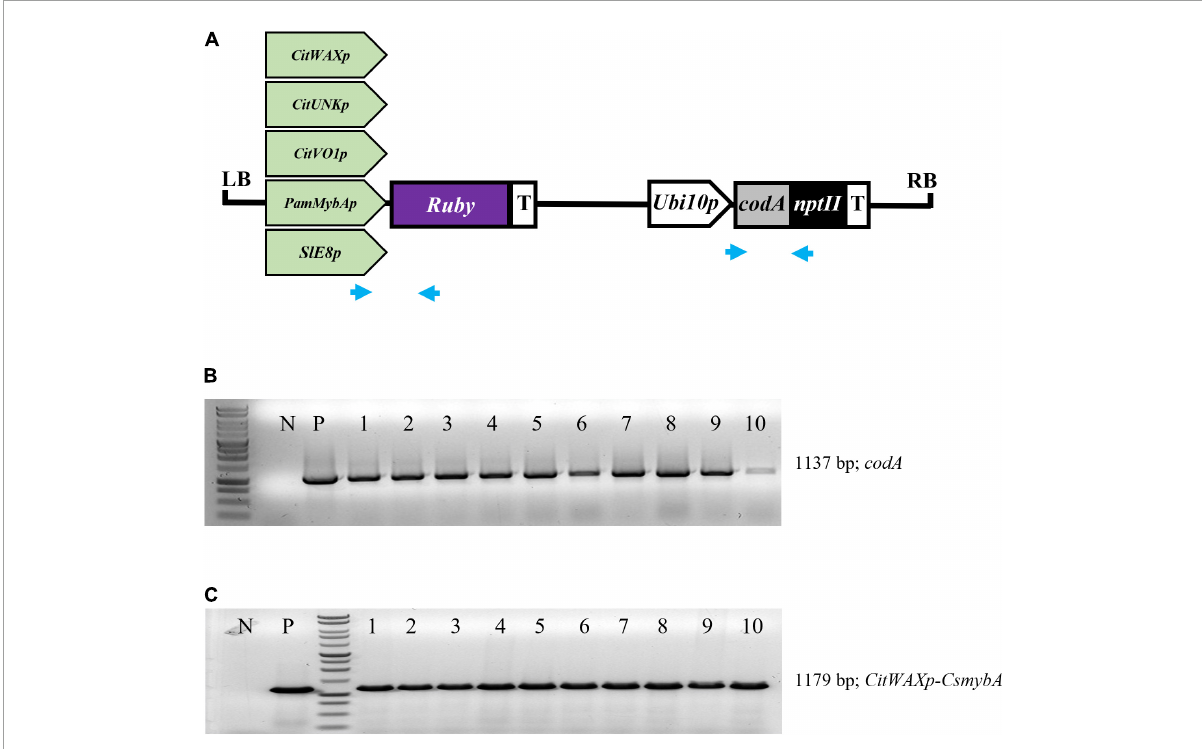
FIGURE1 (A) Schematic representation of the promoter- Ruby construct T-DNAs. The codA-npt II selection marker gene is under the control of the Arabidopsis Ubiquitin10 promoter ( Ubi10p ) and nopaline synthase transcriptional terminator (T). The test promoters from citrus ( CitWaxp , CitUNKp , and CitVO1p ) plum ( PamMybAp ) and tomato ( SlE8p ) are shown upstream of the Ruby ( CsmybA1 ) gene. LB and RB designate the Agrobacterium left and right borders. Blue arrows indicate the approximate position of the codA and Ruby primers used for molecular validation. (B) PCR confirmation of the presence of codA transgene in 10 independent events. (C) PCR confirmation of the presence of the CitWaxp-Ruby sequence. P designates a sample with a plasmid DNA template. N indicates genomic DNA from wildtype Mexican lime. MW indicates molecular marker (Promega, 1 kb DNA ladder,